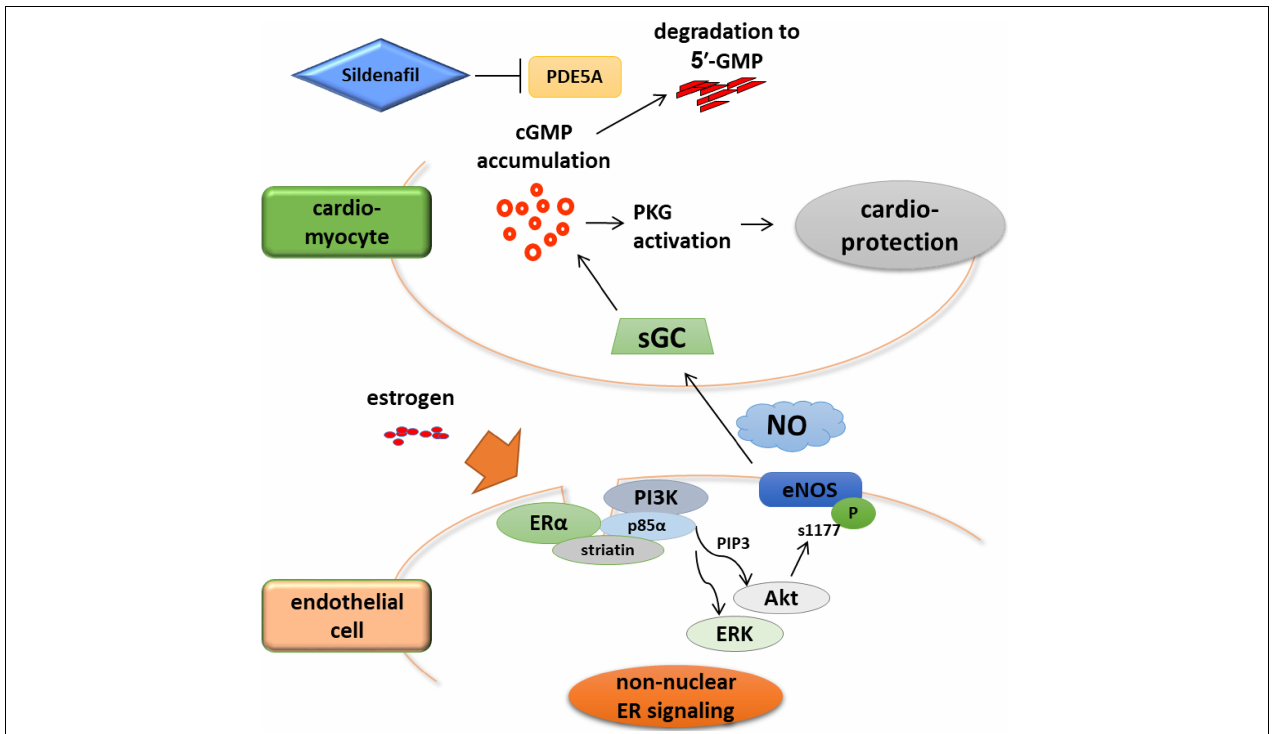
FIGURE 1 | Rapid non-nuclear ER α signaling is indispensable for estrogen to provide NO that activates sGC. ER α non-nuclear signaling requires the interaction between ER α and striatin, a scaffold protein residing at caveolae. A transgenic mouse line in which ER α non-nuclear signaling was selectively disrupted showed that ER α non-nuclear signaling was indispensable to the therapeutic efficacy of cGMP-PDE5 inhibition in heart failure but not to that of sGC stimulation. These data imply the advantage of sGC stimulation over PDE5 inhibition as a potential therapeutic strategy in treating heart failure in post-menopausal women, highlighting the need for female-specific therapeutic